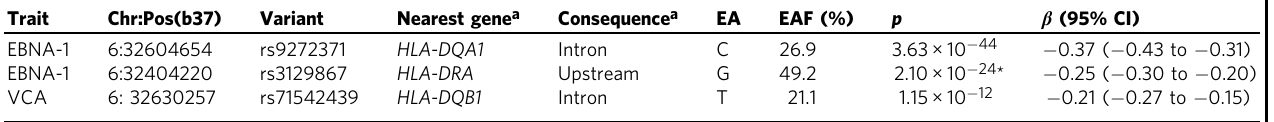
Table 3 Loci with signi fi cant evidence of association with anti-EBV IgG levels ( N = 4365).